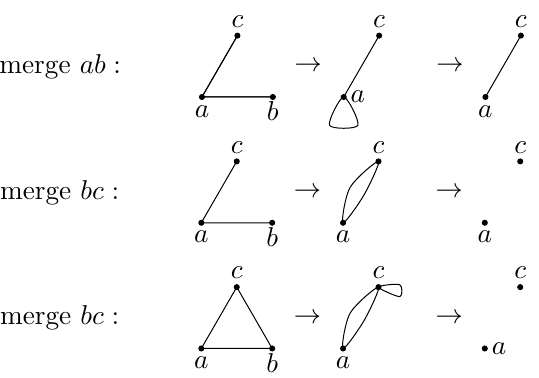
Figure 12 . Three examples of the “merge and delete” prescription. In the first figure, a loop is formed after merging and then deleted, in the end q 2 is reduced to q ; in the second figure, a double edge is formed after merging and then deleted, and q 2 is reduced to 1 ; in the third figure, a loop and a double edge are formed and deleted, as a result q 3 is reduced to 1